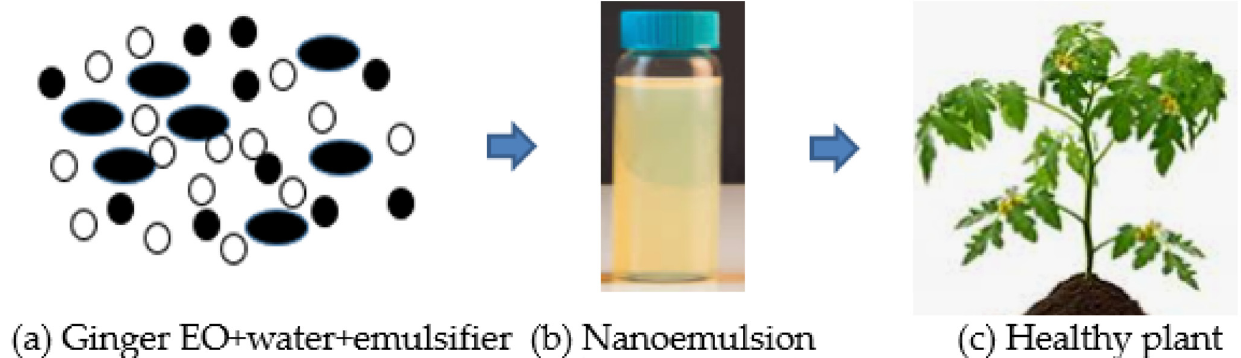
Figure 3. ( a ) Combination of ginger essential oil (EO), water, and emulsifier (tween-80). ( b ) The final product of ginger EO nanoemulsion after the formulation. ( c ) The application of ginger essential oil (EO) formulation is promising and could be utilized to protect the plant from fungal